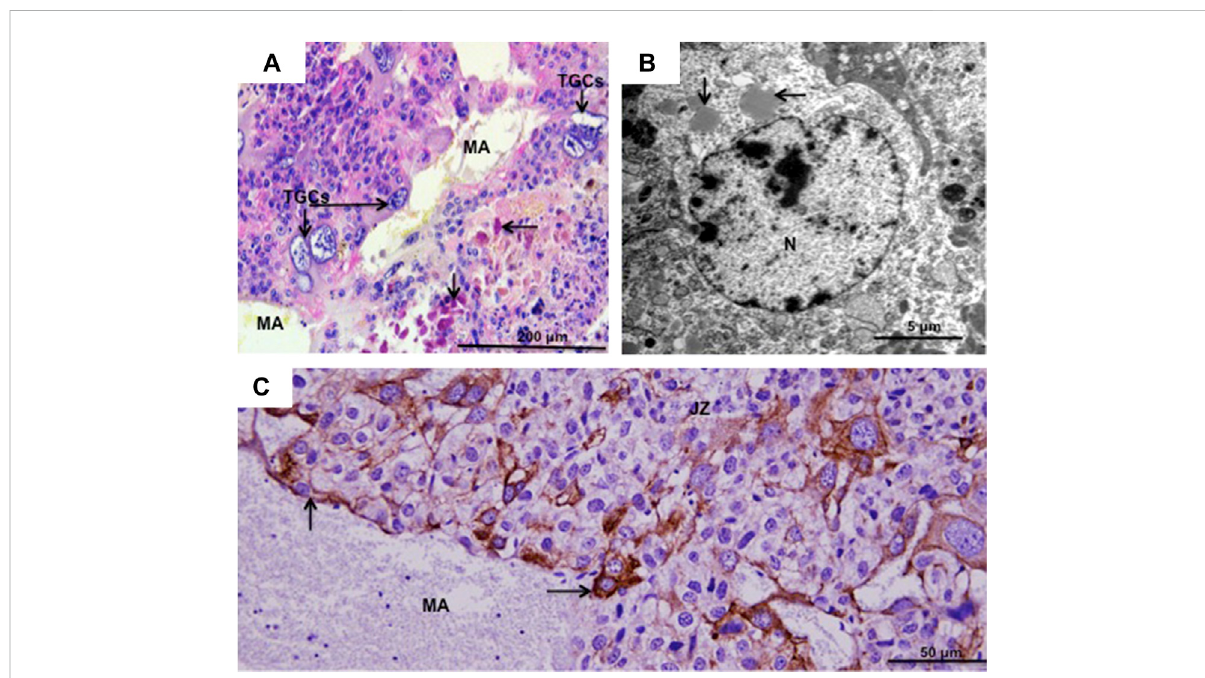
FIGURE 3 Spiral artery trophoblast giant cells. (A) Hylaeamys megacephalus. Maternal artery (MA) surrounded by uterine natural killer cells and large trophoblast giant cells (TGCs). Arrows = PAS-positive granules in uterine natural killer cells. Periodic acid-Schiff. (B) . Euryoryzomys sp. Granules (arrows) in the cytoplasm of uterine natural killer cells. N = nucleus. Transmission electron microscopy. (C) Necromys lasiurus . Maternal artery (MA) near the junctional zone (JZ) lined by large TGCs (arrows) and without the smooth muscle layer and endothelium.